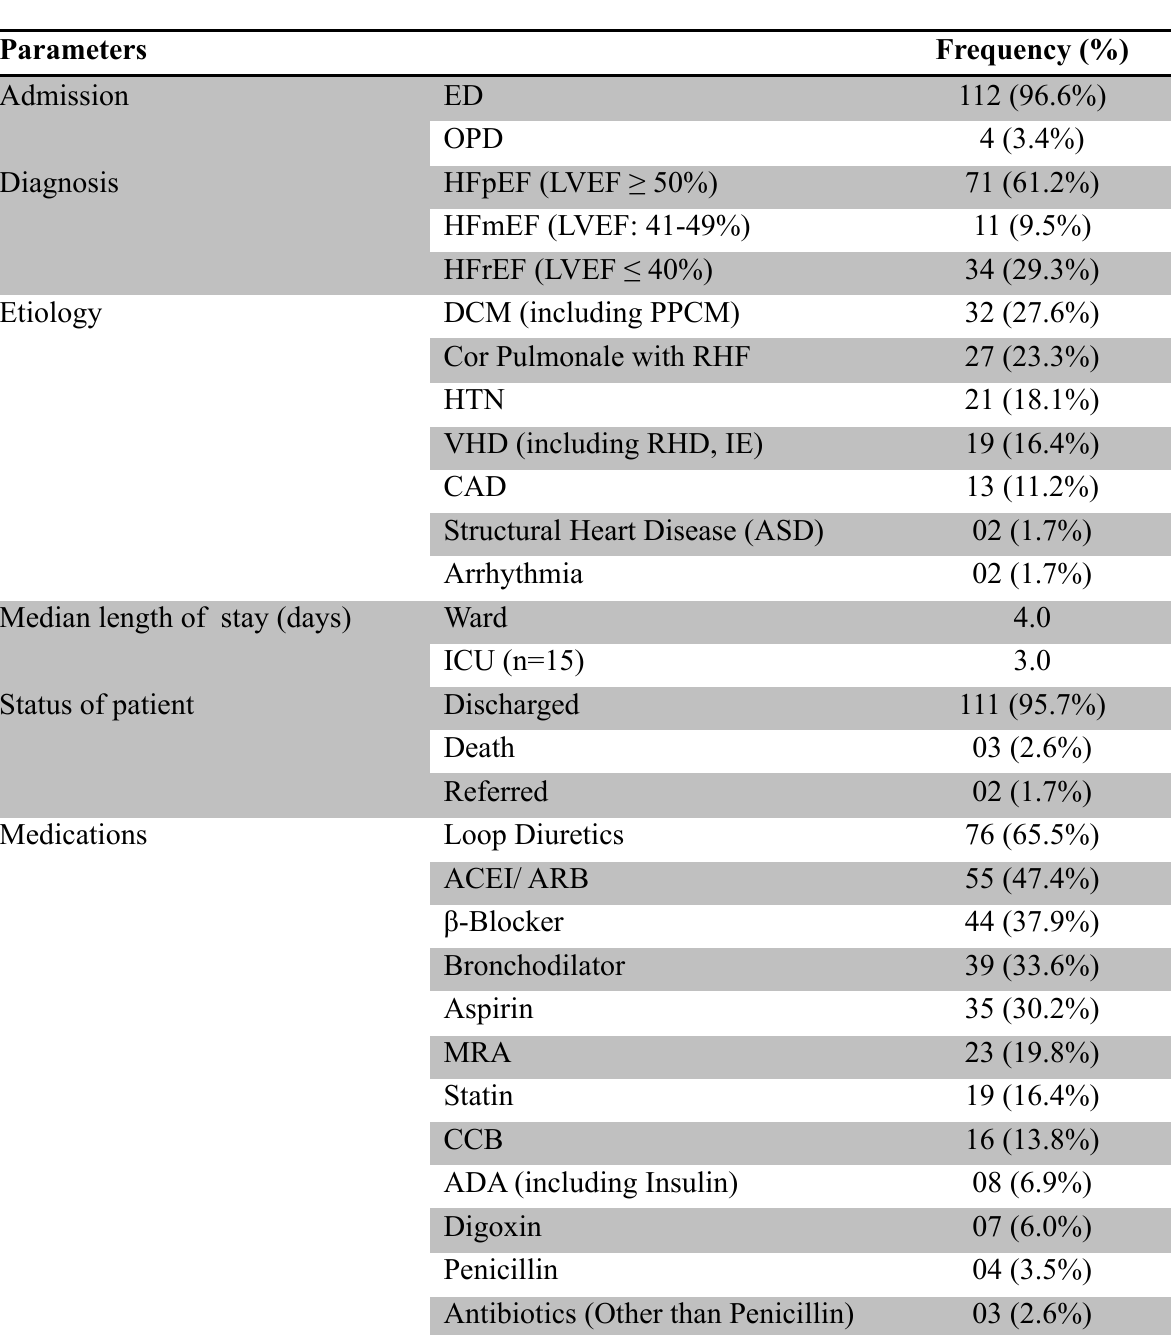
Table 4: Heart failure hospitalization parameters (n=116)